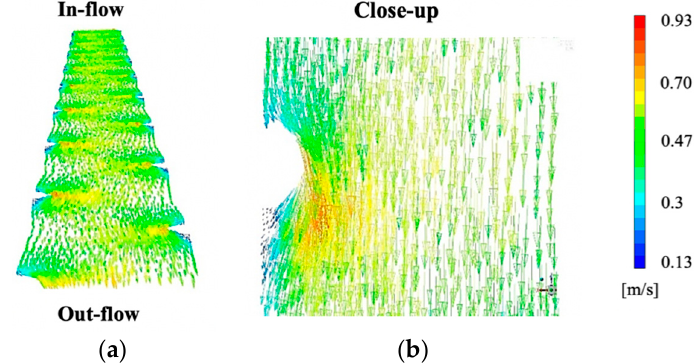
Figure 5. A 3D view of the 70% occluded channel simulated at 0.575 m/s demonstrating the effect of curvature on the velocity profile: ( a ) diagonal-view and ( b ) close-up of dot spacer. Simulations were performed at 0.575 m/s, as this was the highest cross-flow velocity (CFV) used in experimental testing and this most likely to give visually disparate results.